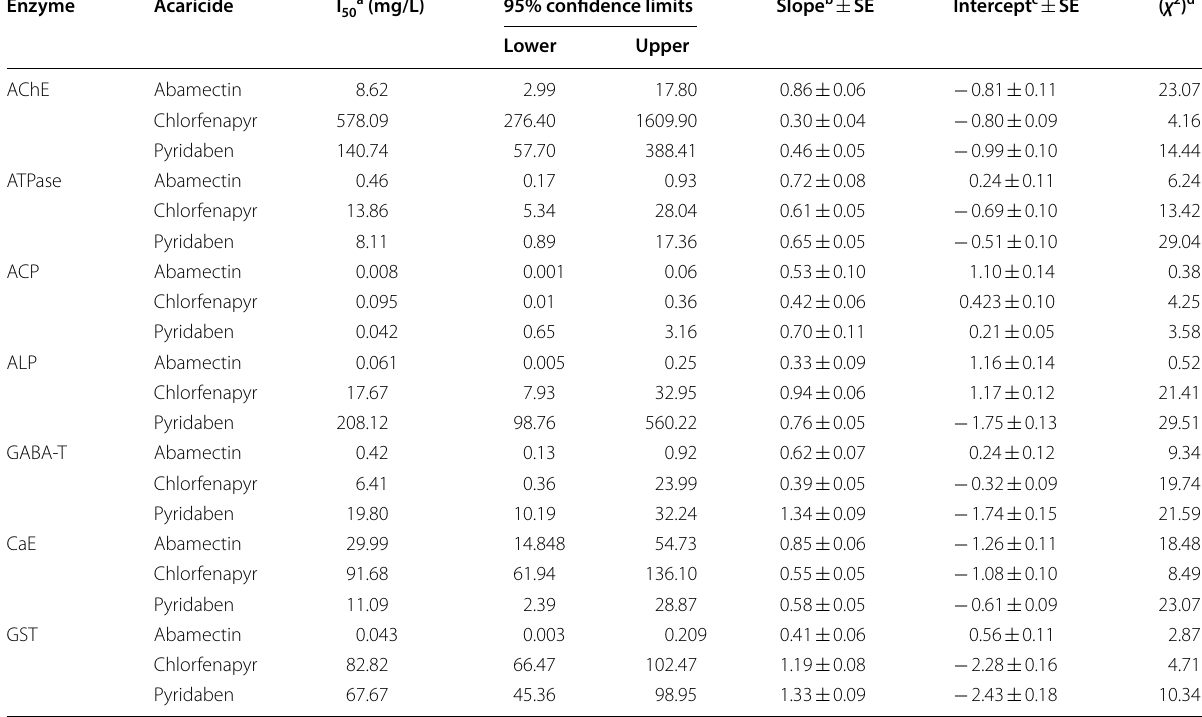
Table 6 The in-vitro effect of technical abamectin, chlorfenapyr, and pyridaben on AChE, ATPase, ACP, ALP, GABA-T, CaE, and GST activities isolated from the adult females of two spotted spider mites T.